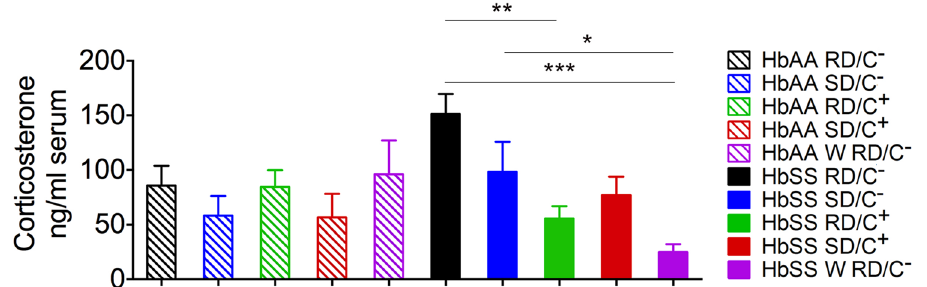
Figure 3. Effect of enriched diet and companionship on levels of corticosterone in serum of male sickle mice . As described in Fig. 1(a–h) male mice were treated with regular or sickle diet in the absence or presence of a female companion for 3 weeks, and a group of male mice fed sickle diet in the presence of a companion upto 8 months of age were withdrawn (W) from sickle diet and the companion for 3 weeks. Blood was drawn after 3 weeks of treatments and after 3 weeks of withdrawal for corticosterone analysis. Regular diet without companionship, RD/C−, nSS = 9, nAA = 9; regular diet with companionship, RD/C+, nSS = 9, nAA = 9; sickle diet without companionship, SD/C−, nSS = 10, nAA = 9; sickle diet with companionship, SD/C+, nSS = 8, nAA = 9; withdrawn from sickle diet and companionship, W RD/C−, nSS = 9, nAA = 10; one-way ANOVA with Bonferroni’s post-hoc test, * p < 0.05, ** p < 0.01, *** p <